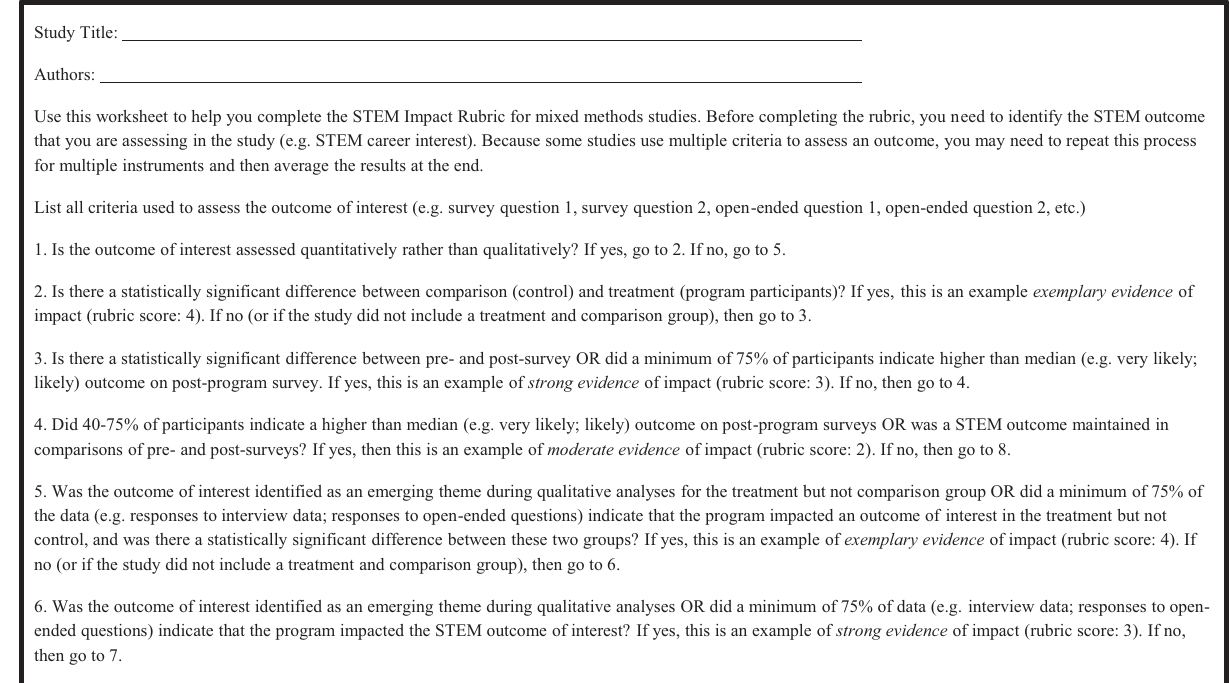
FIGURE 6 | STEM Impact Rubric worksheet for mixed methods